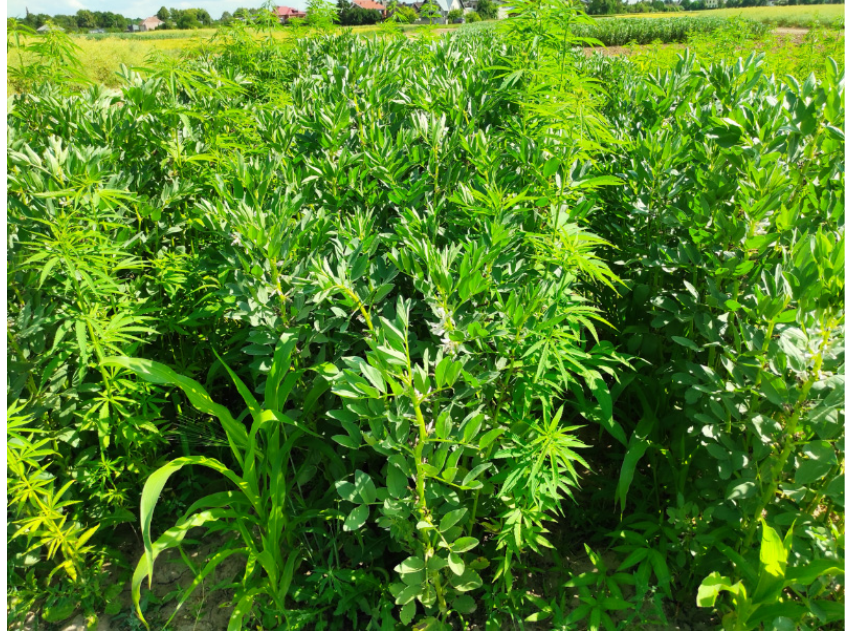
Figure 6. Crop development.